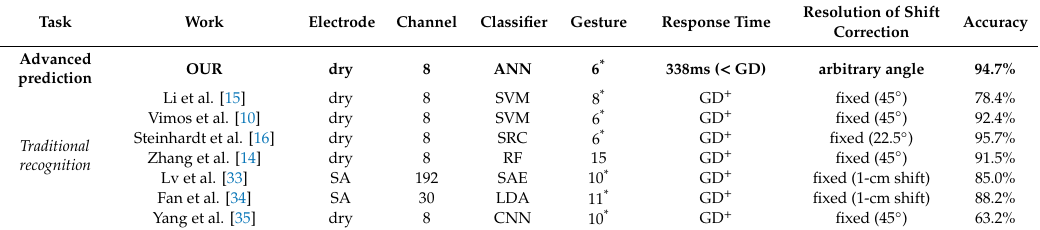
Figure 7. Acquired raw sEMG signals of two pre-defined gestures from Myo armband mounted on forearm. ( a ) WF. ( b ) WE. Red dashed box represents anterior forearm muscular region, green dashed box represents posterior forearm muscular region. Table 4. The results of di ff erent hand gesture